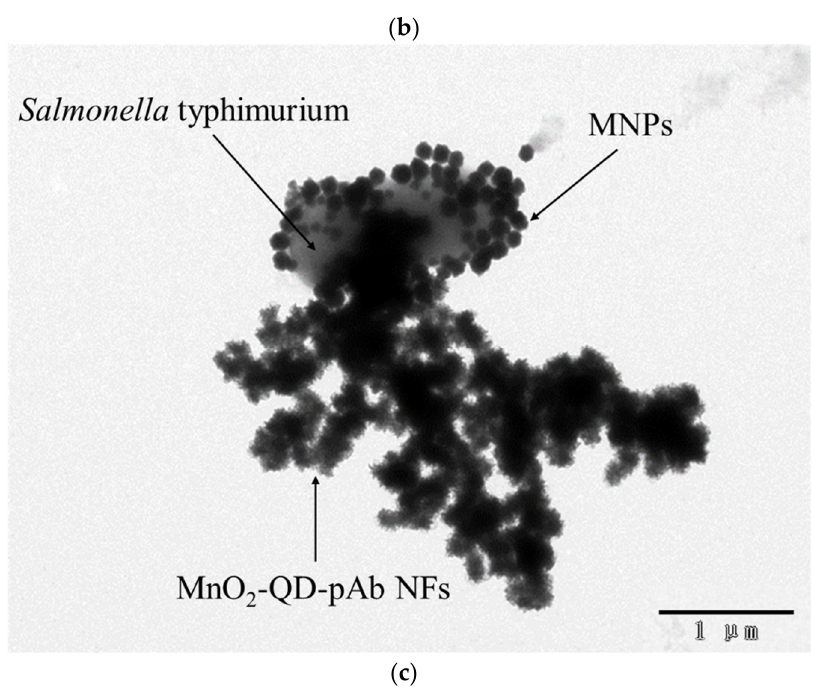
Figure 4. ( a ) The spectra of the MNP-bacteria-MnO 2 -QD complexes at different concentrations from 1.0 × 10 2 CFU/mL to 1.0 × 10 7 CFU/mL; ( b ) The linear relationship between the fluorescent intensity and the bacterial concentration; ( c ) The TEM image of the MNP-bacteria-MnO 2 -QD complexes.